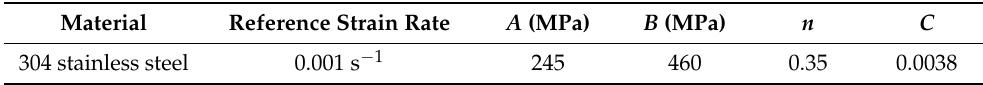
Table 2. Johnson–Cook model parameters of 304 stainless